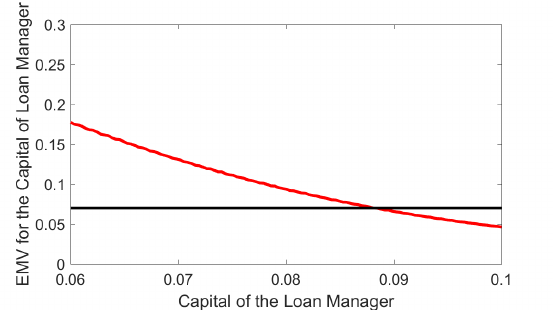
Figure 9. EMV of K j